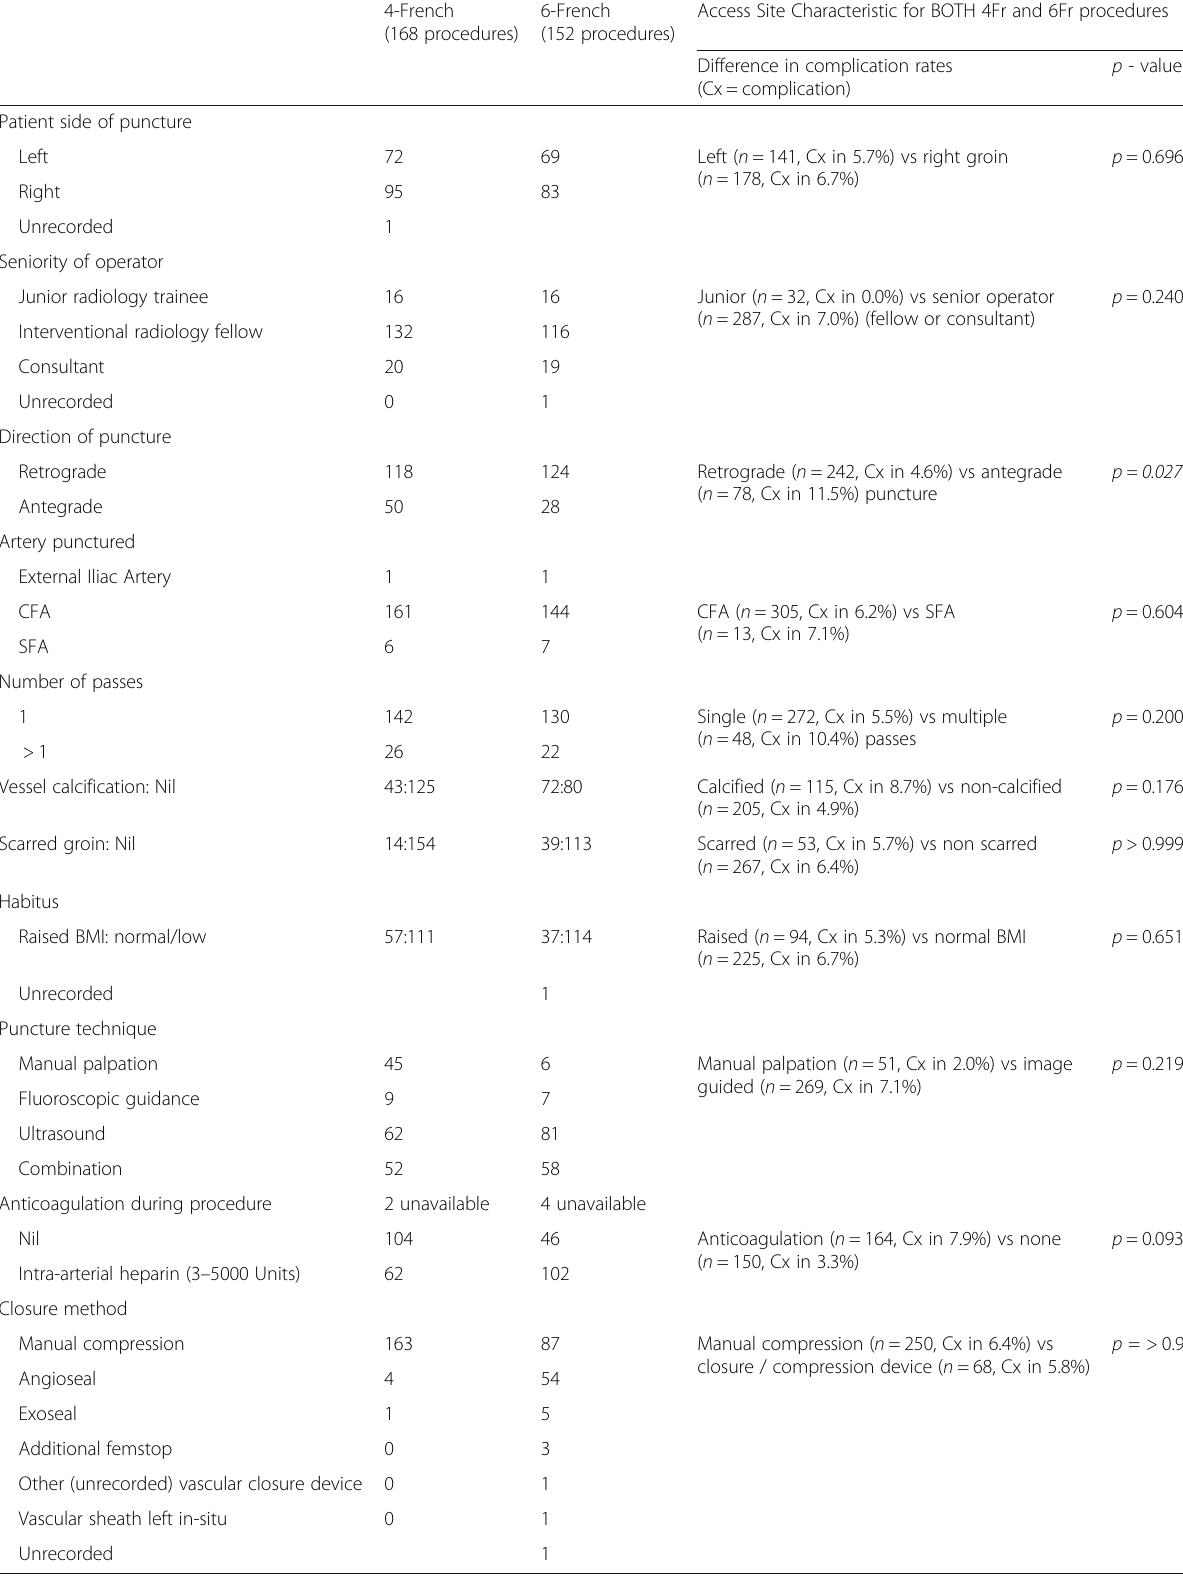
Table 2 Arterial access